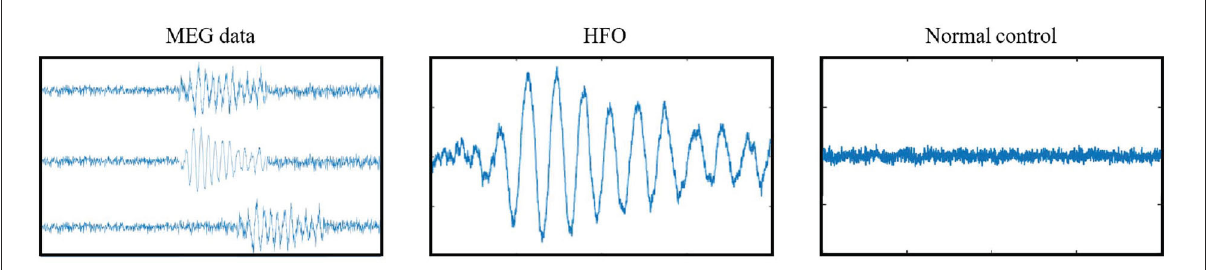
FIGURE1 Examples of gold standard signals.